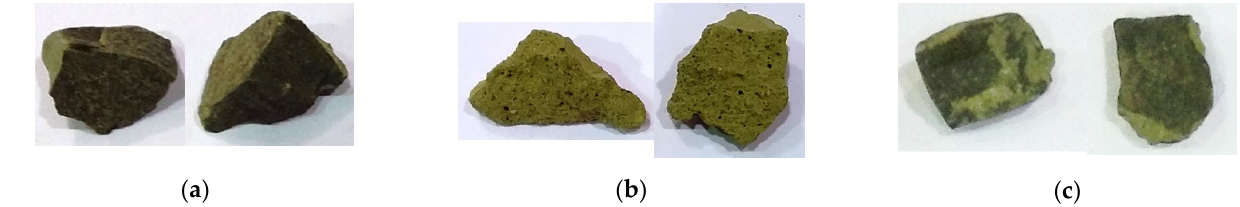
Figure 3. Density distribution of the concretes comminuted at 19.1 mm (size 4.75/19.1 mm). Liberated coarse aggregate ( a ), liberated cement paste ( b ), and middlings ( c ).